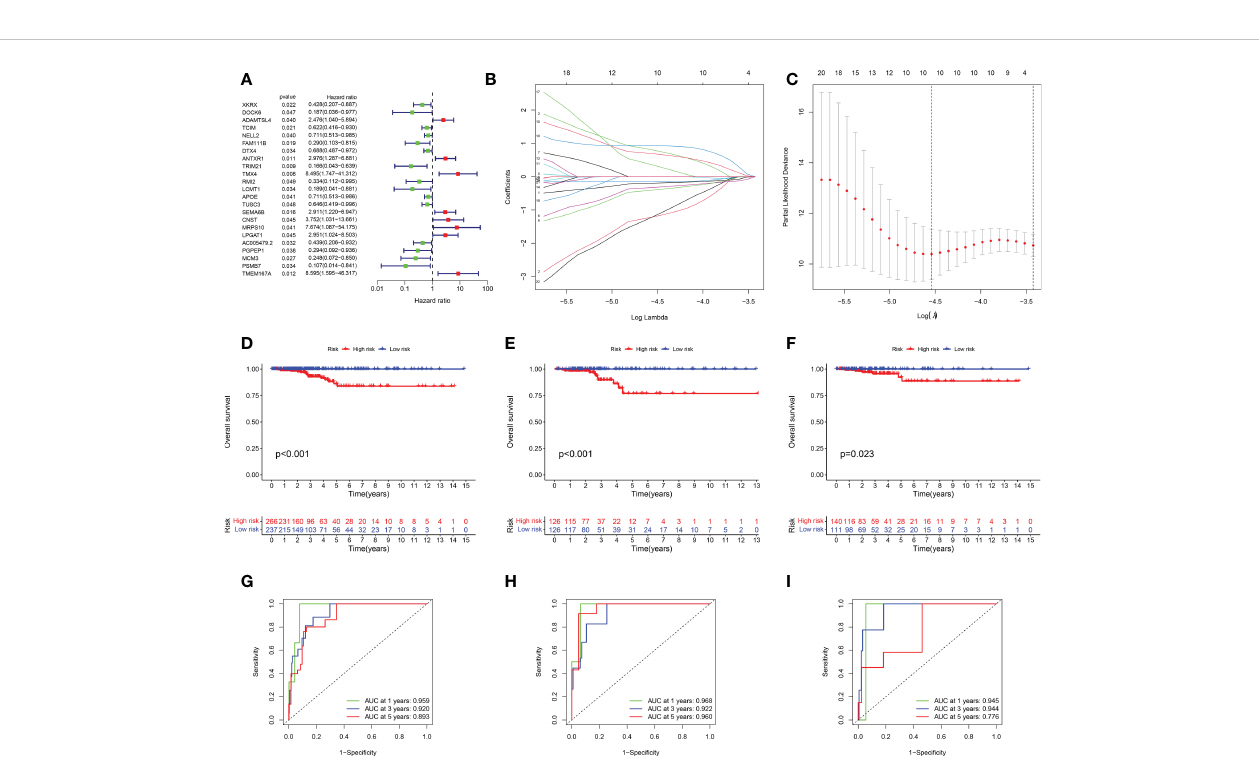
FIGURE 3 Identi fi cation and validation of the senescence-related signature. (A) Univariate Cox regression analysis identifying 23 prognostic DEGs. (B) Coef fi cients of the LASSO analysis. (C) The senescence-related signature obtained six prognostic genes with a minimum lambda value. (D – F) K-M survival analysis showing a signi fi cant survival difference between low- and high-risk THCA across the TCGA-all, TCGA-training, and TCGA-test subsets. (G – I) ROC analysis showing the stable prediction ability of the senescence-related signature across TCGA-all, TCGA-training, and TCGA-test